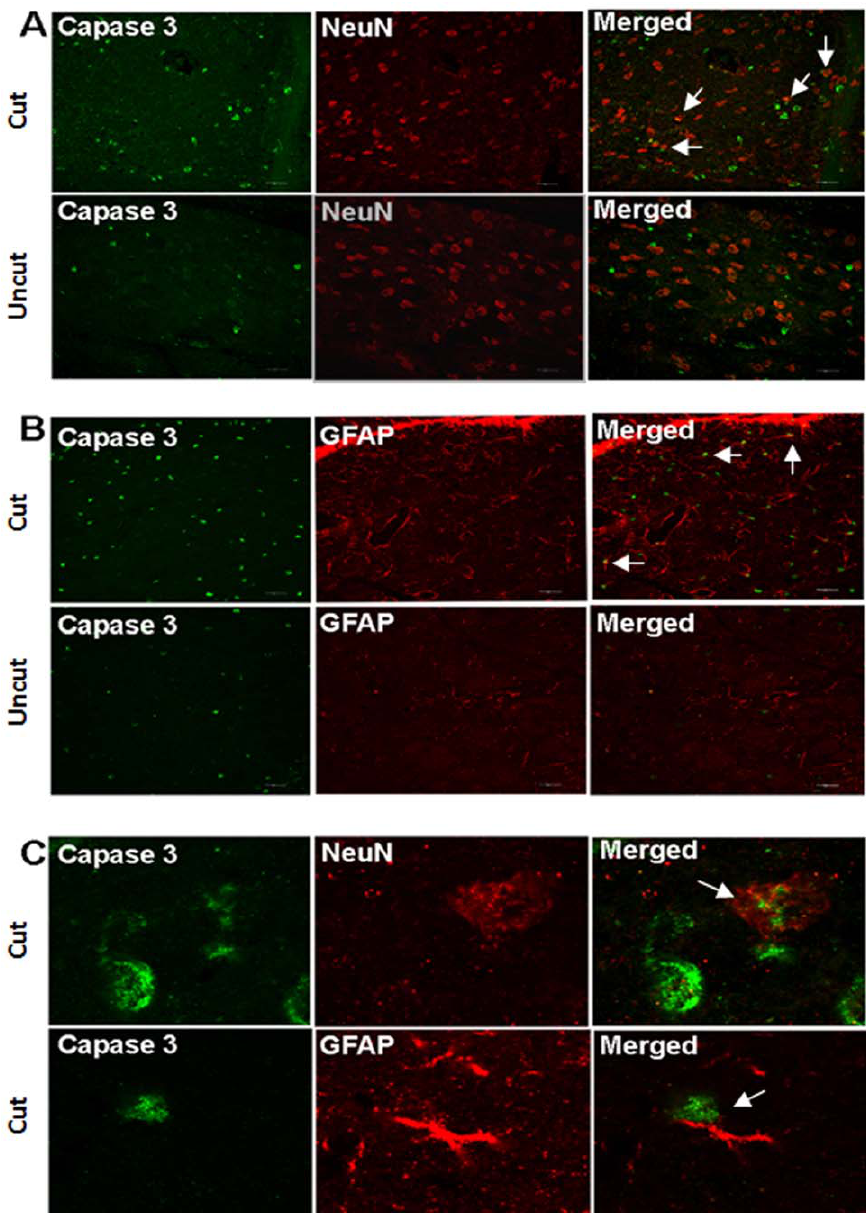
Figure 6. Immunostaining of the dLGN using Caspase 3/NeuN and Caspase 3/GFAP antibodies. Both NeuN –positive neurons and GFAP- positive glial cells undergo apoptosis in the dLGN. (A) Double staining of Caspase 3 and NeuN. Arrows indicate apoptotic neurons. (B) Double staining of Caspase 3 and GFAP. Arrows indicate apoptotic glial cells. (C) High magnification of the confocal microscope shows co-localisation of Caspase 3/ NeuN and Caspase 3/GFAP in individual cells.